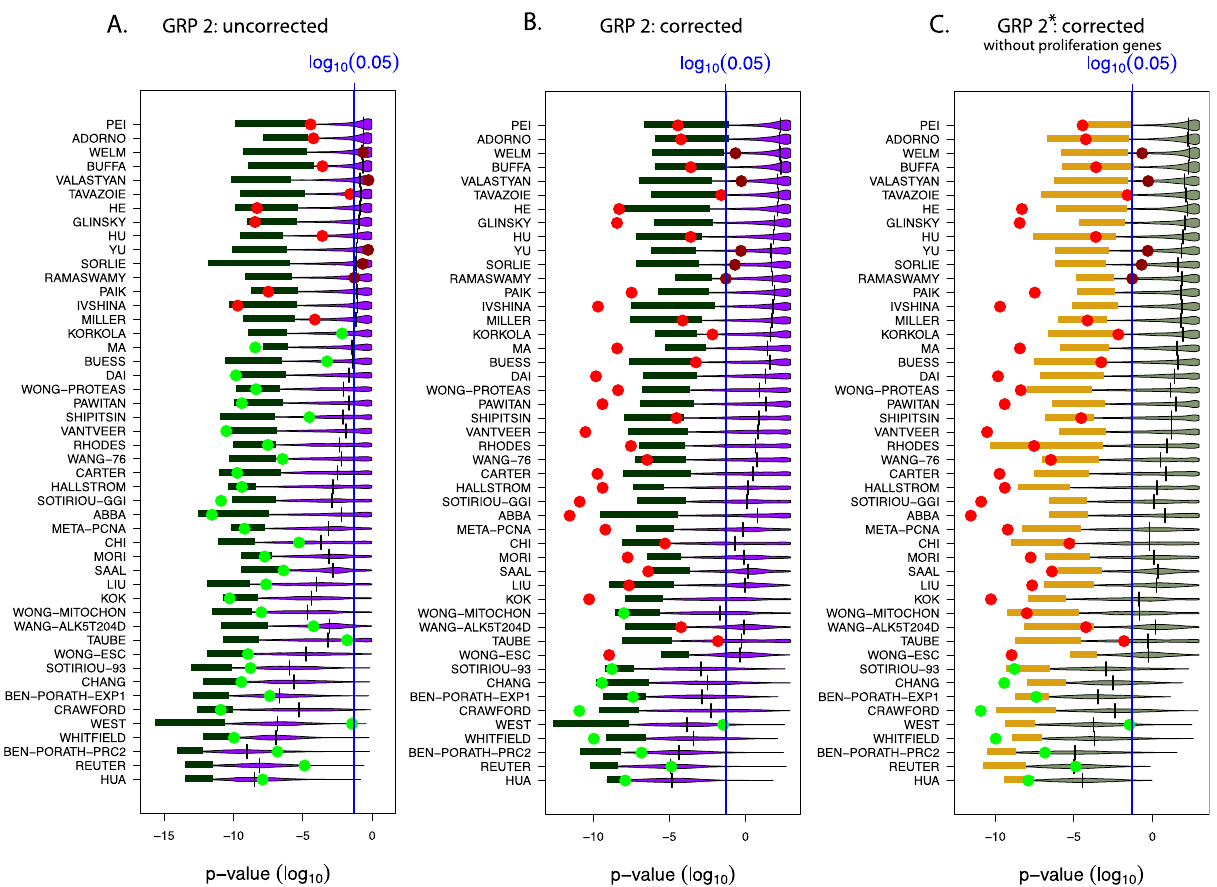
Figure 6. Results for gene removal procedure 2 for the NKI data. The results in ( A ) and ( B ) are for the minimal accuracy (see Fig. 5A,B), whereas A is for uncorrected p-values and B for Bonferroni corrected p-values. The results in ( C ) correspond to Fig. 5C where all GO-terms on all hierarchy levels have been removed and, in addition, all proliferation genes have been